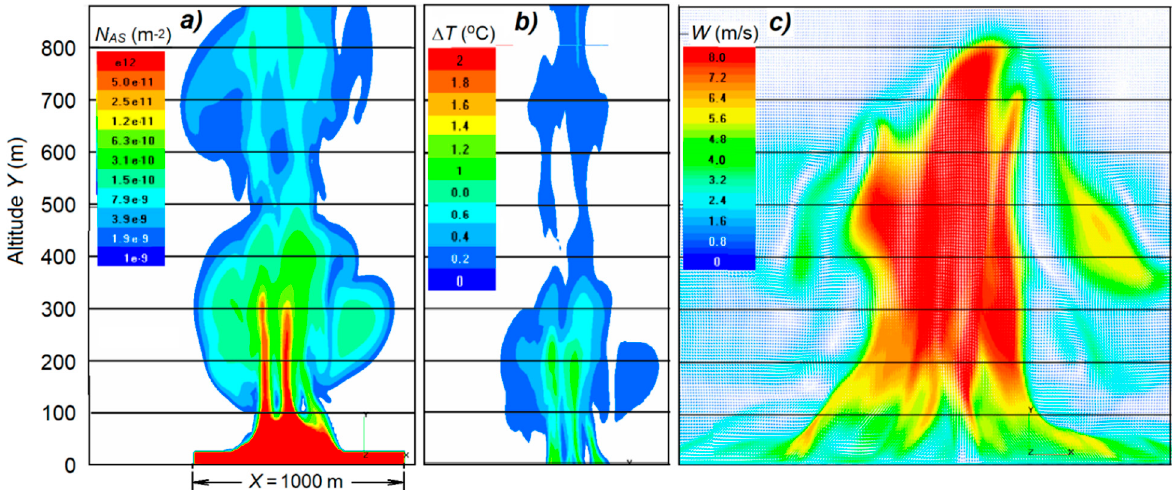
Figure 10. Fields of aerosol concentration ( a ), temperature excess ( b ) and updraft velocity ( c ) gener- ated in 1 h by 5 continuous sources located every 200 m in windless atmosphere with TLR = 8.5 °C/km.